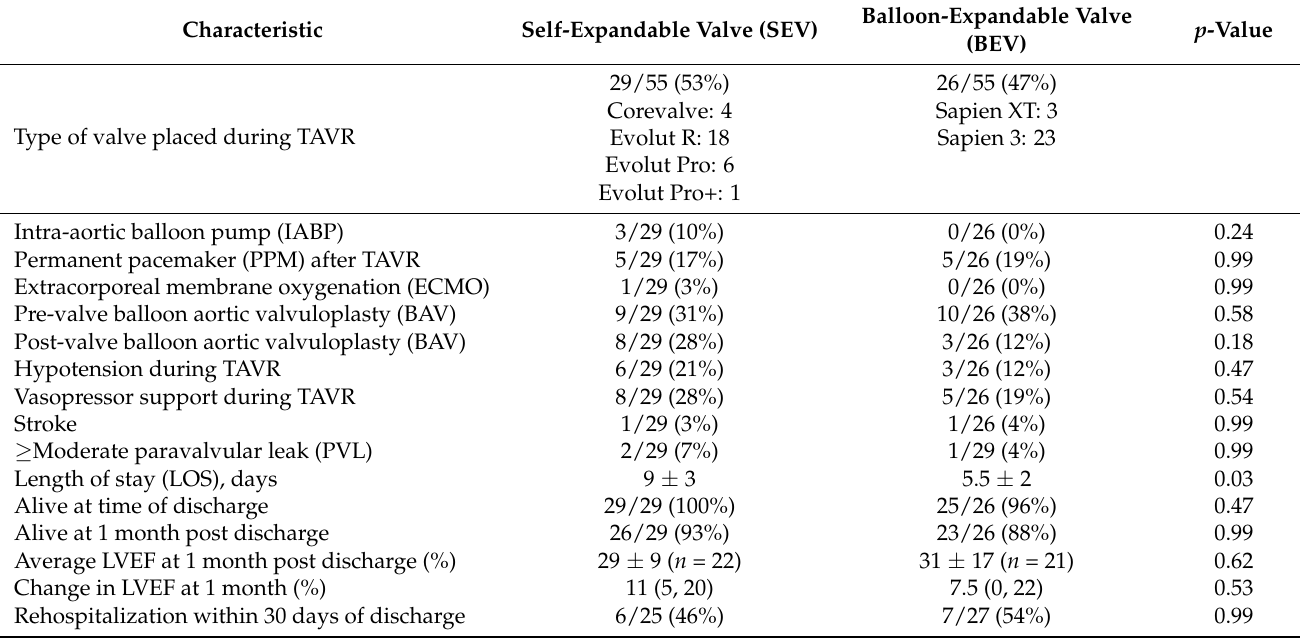
Table 4. Subgroup Analysis within VLEF Group Based on Valve